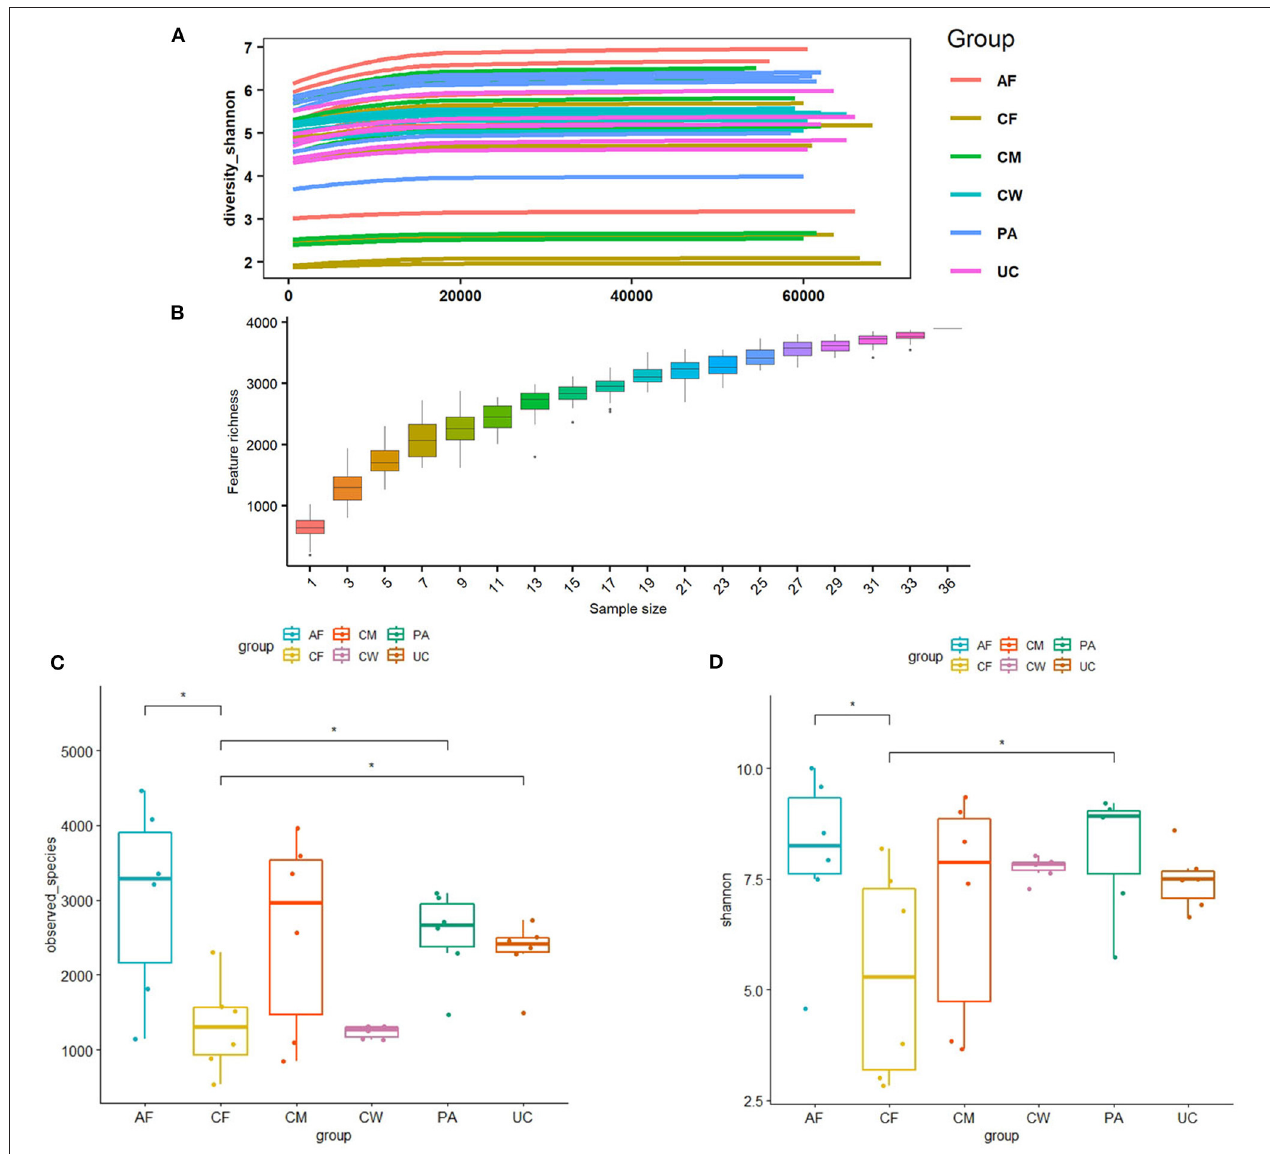
FIGURE 1 | (A) Shannon diversity sparse curves, (B) box plot dilution curves, (C) box plot of the Shannon diversity index, and (D) observed characteristic index of all samples. AF, cow amniotic fluid; CF, calf meconium; CM, cow colostrum; CW, cow feces; PA, cow placenta; UC, cow umbilical cord.